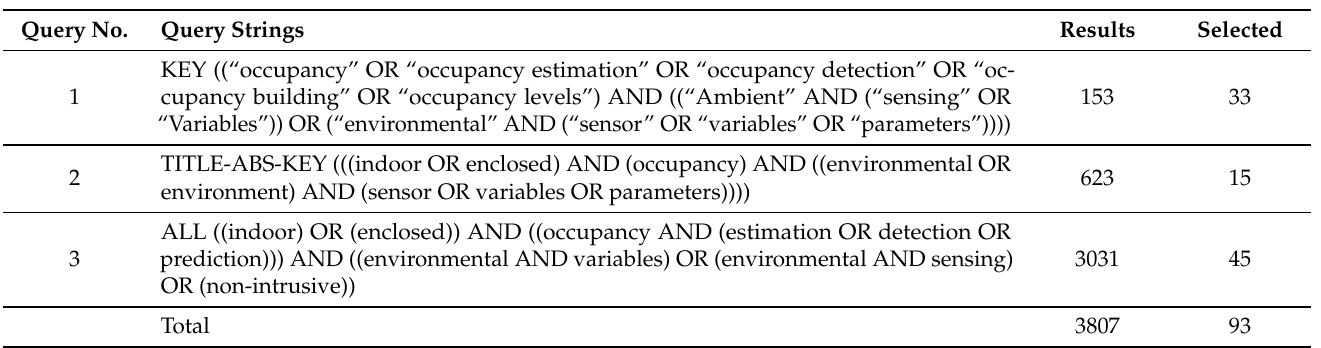
Table 2. Summary of selected